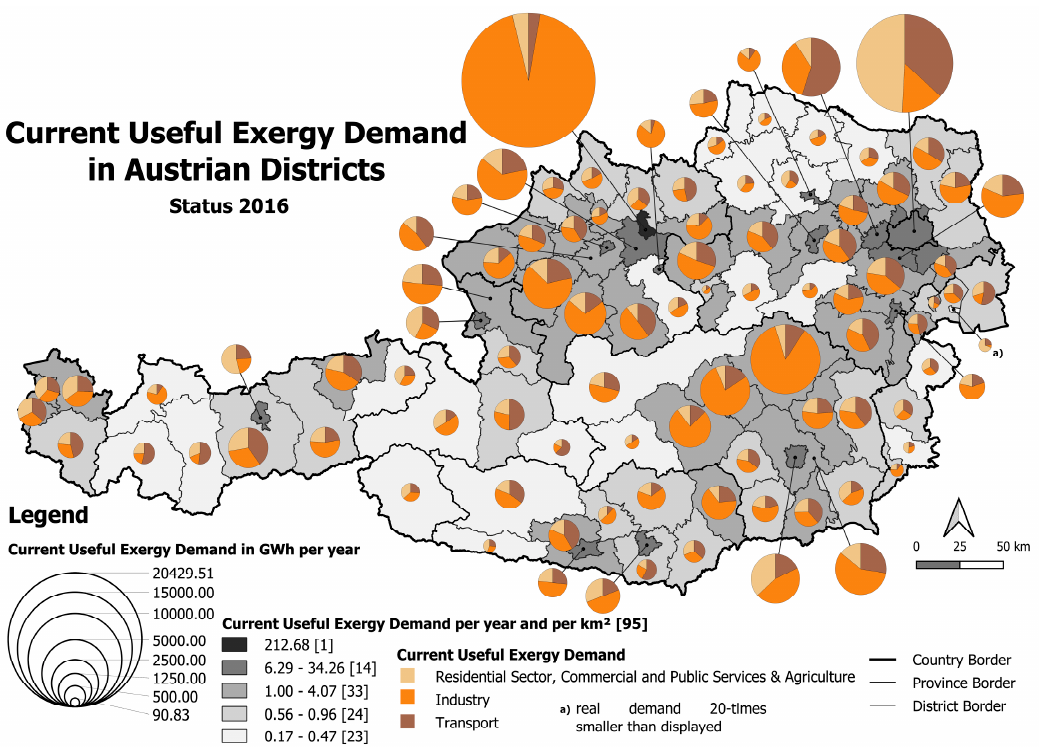
Figure 8. Current useful exergy demand in Austrian districts. The absolute and relative demand is represented by the size of the pie charts and by the gray scales, respectively. The maximum demands can be found in industrial and urban areas (map source: Statistics Austria - data.statistik.gv.at).